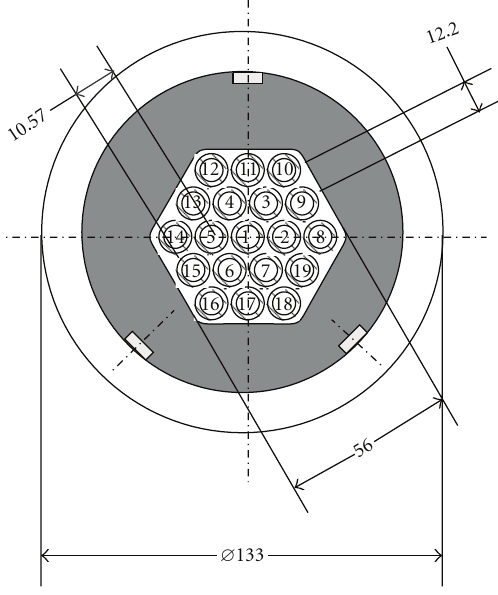
Figure 2: Cross section of the core